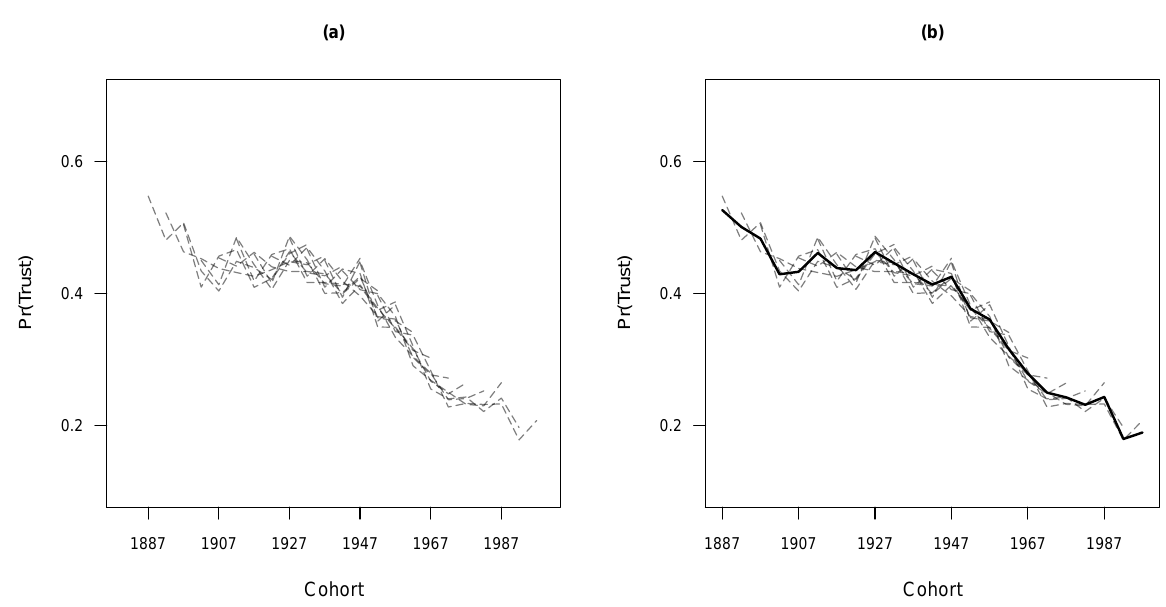
Figure 10: Local diachronic cohort curves. Notes: (a) displays a spaghetti plot of local diachronic cohort curves. (b) displays local diachronic cohort curves with the (overall) diachronic cohort curve overlaid. Calculations γ k + π k + i − I for k = 1, . . . , K in each age group i . Local curves are shown with are based on θ 2 ( k − k ∗ ) + dashed lines, whereas the overall curve is shown with a bold solid line. Each local curve has a length equal to the number of periods in the data ( J = 10). All estimates are based on a diachronic L-APC logistic regression (cid:101) (cid:101) model. Outcome is social trust, coded so that 1 = “can trust” while 0 = “can’t be too careful” or “depends.” Results adjusted using sampling